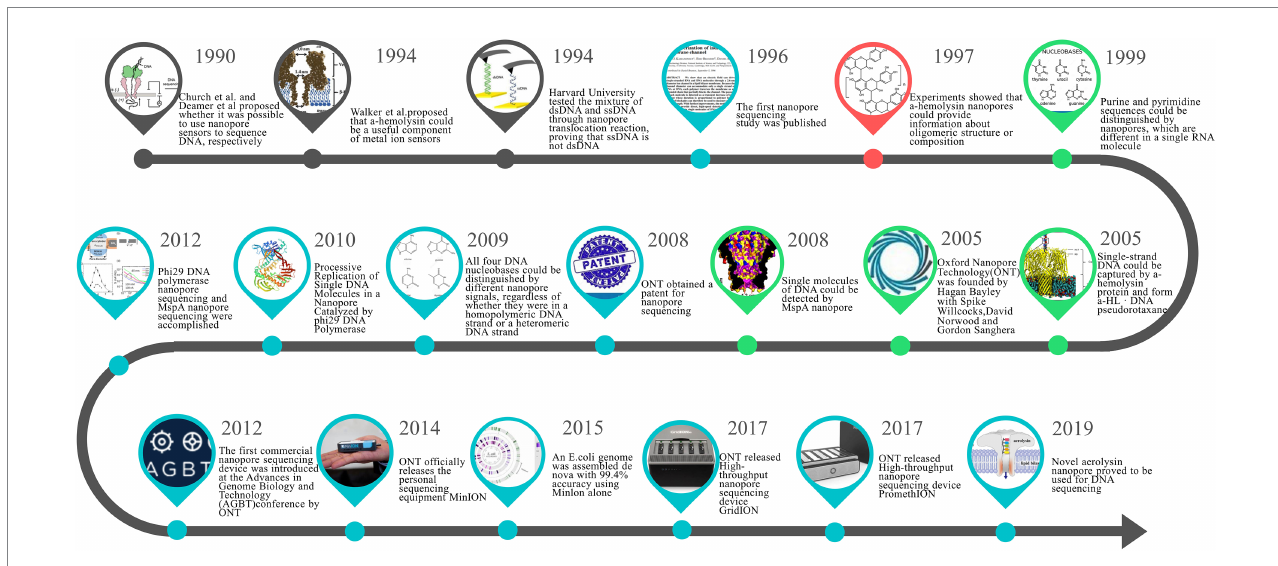
FIGURE 2 Milestones in the development of nanopore sequencing technology